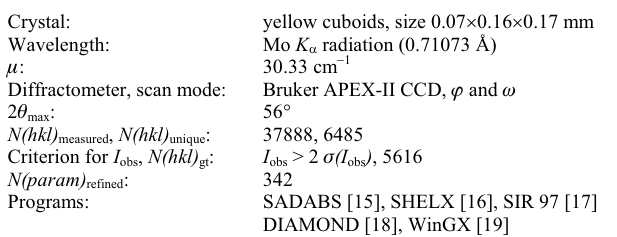
Table 1. Data collection and handling.